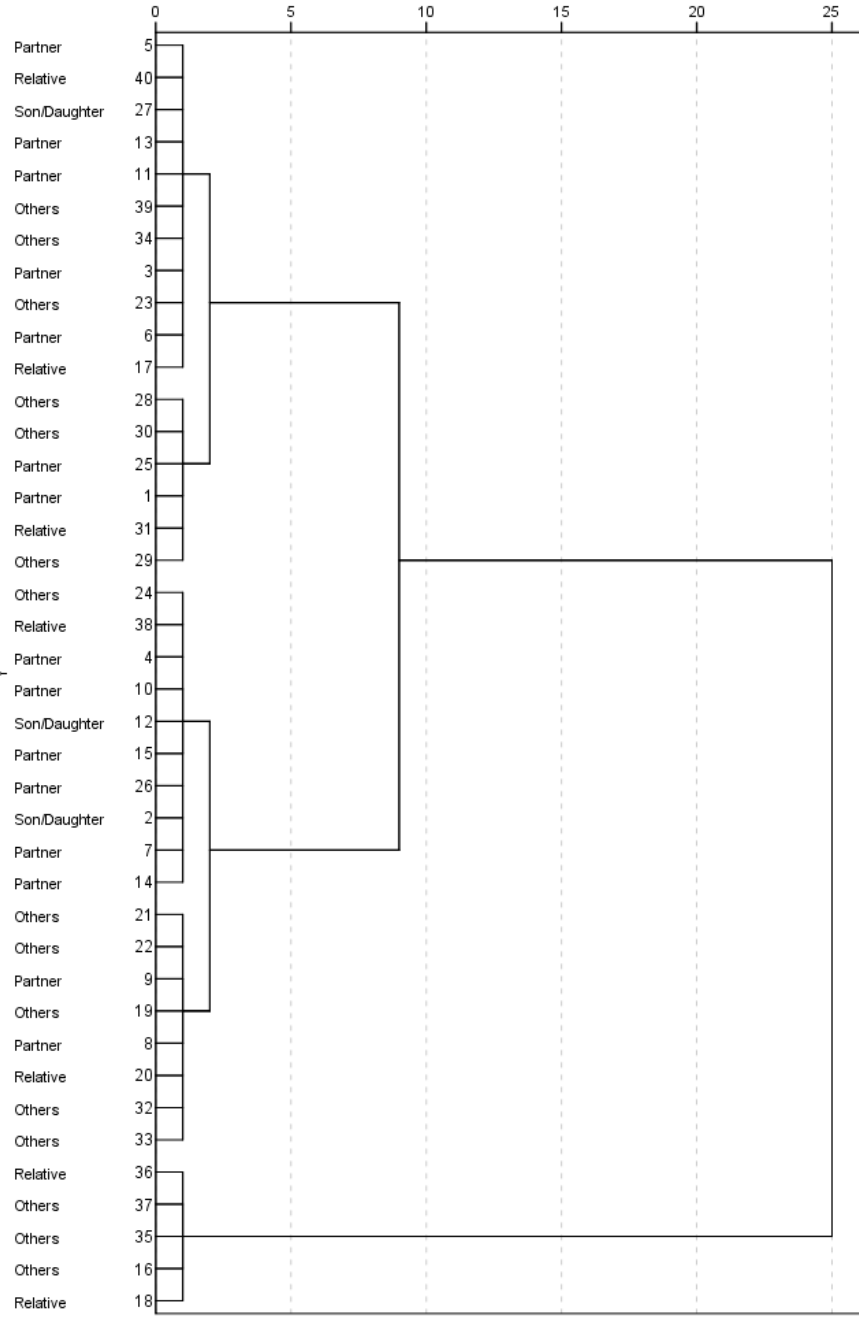
Figure 3. Tree diagram regarding satisfaction COPM and role scores in hierarchical cluster analysis.